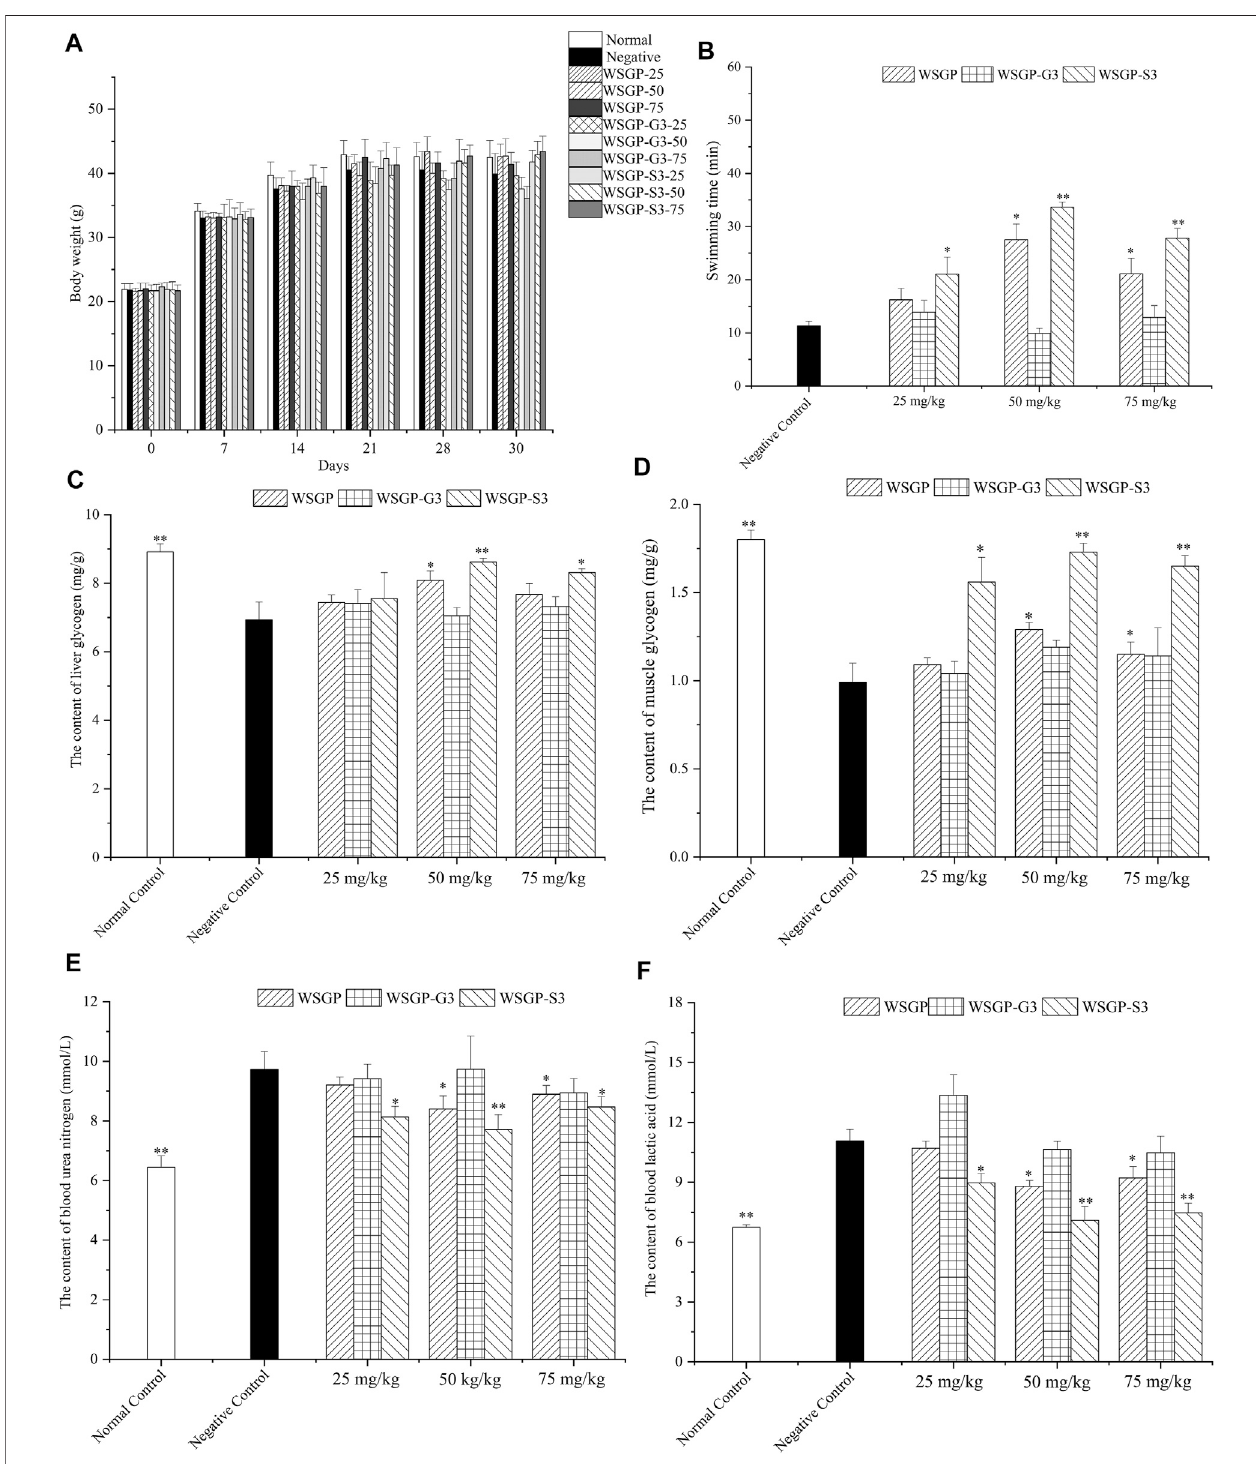
FIGURE 4 | Effect of the polysaccharides on the fatigued mice. (A) The changes of body weight; (B) Swimming time; (C) Liver glycogen; (D) Muscle glycogen; (E) Blood urea nitrogen; (F) Blood Lactic acid. * p < 0.05, ** ,* p < 0.01 vs. the negative control group.